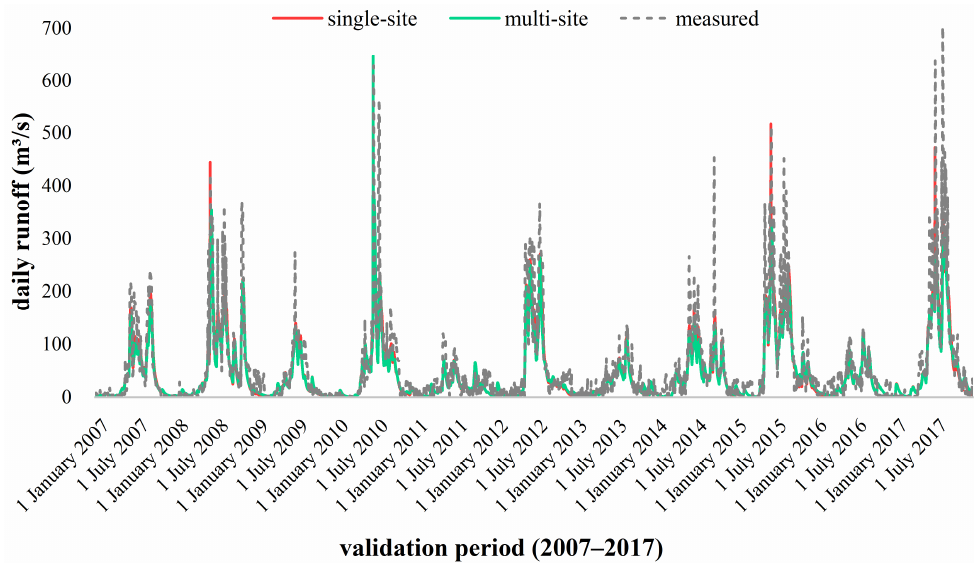
Figure 9. Daily simulated runoff during the validation period.